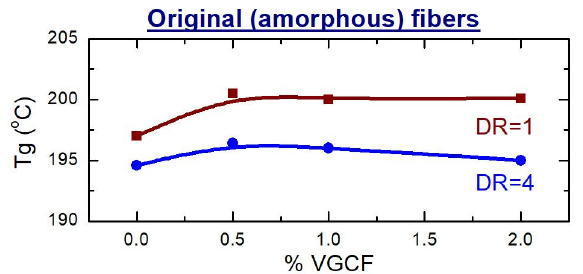
Figure 11. Dependences of the glass transition of the amorphous composite fibers before (DR = 1) and after (DR = 4) orientational drawing on the content of the nanofibers.